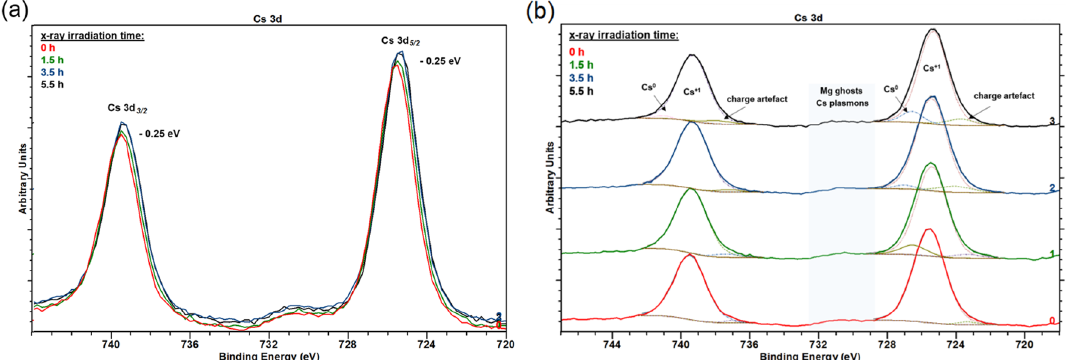
Figure 10. ( a ) Cs 3d photoelectron spectra for p-GaN:Cs surface (sample D) influenced by the X-ray’s irradiation time and ( b ) the same Cs 3d spectra of sample D, stacked and with peak fittings (dashed